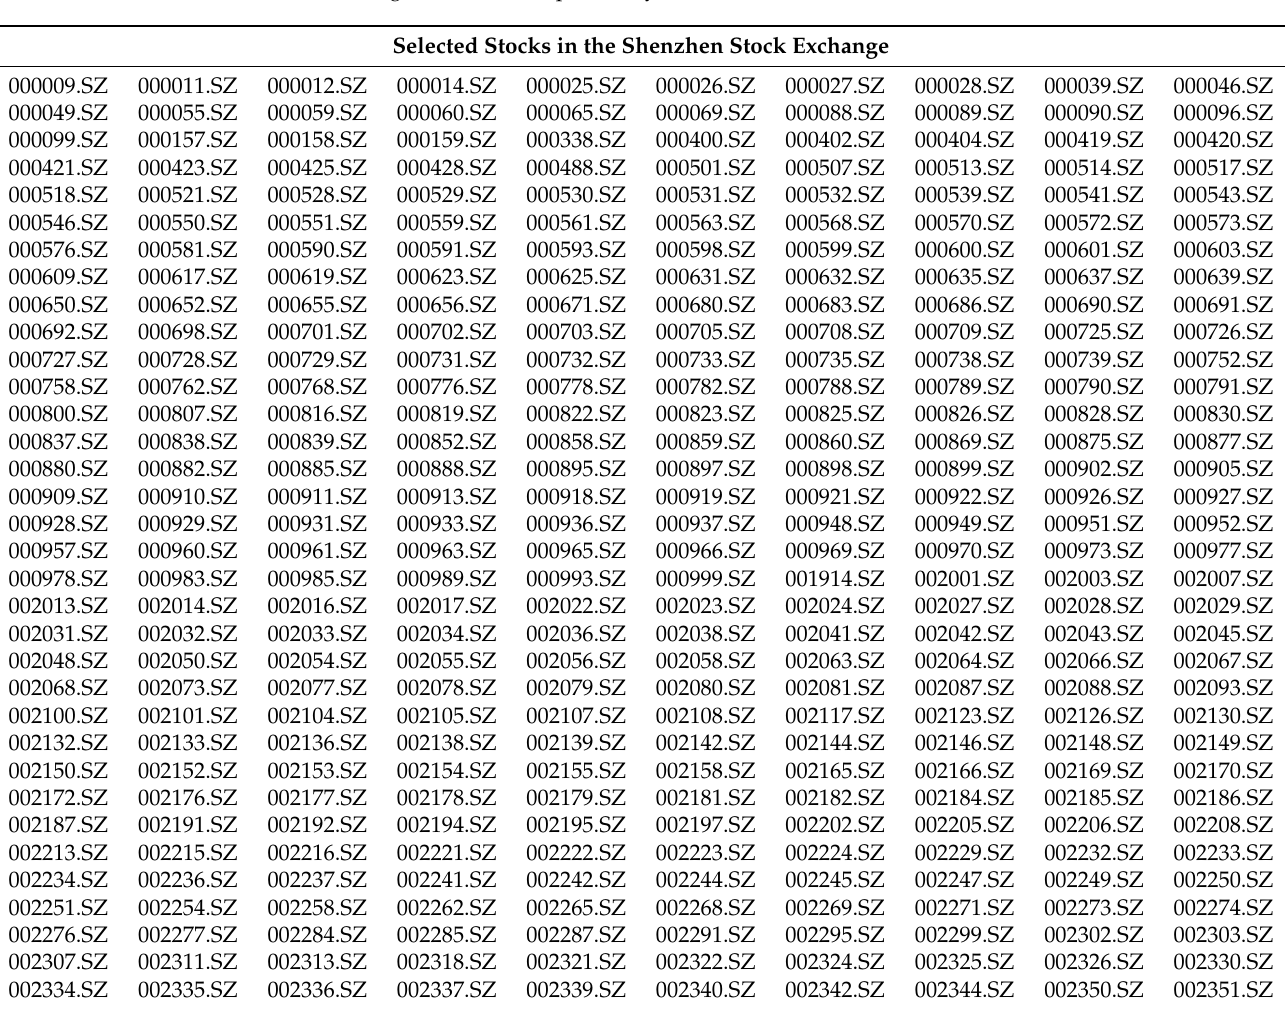
Table A2. Ticker symbol for the 1000 randomly selected stocks in the Shenzhen and Shanghai stock exchanges. This table reports only the stocks traded in the Shenzen market. Selected Stocks in the Shenzhen Stock